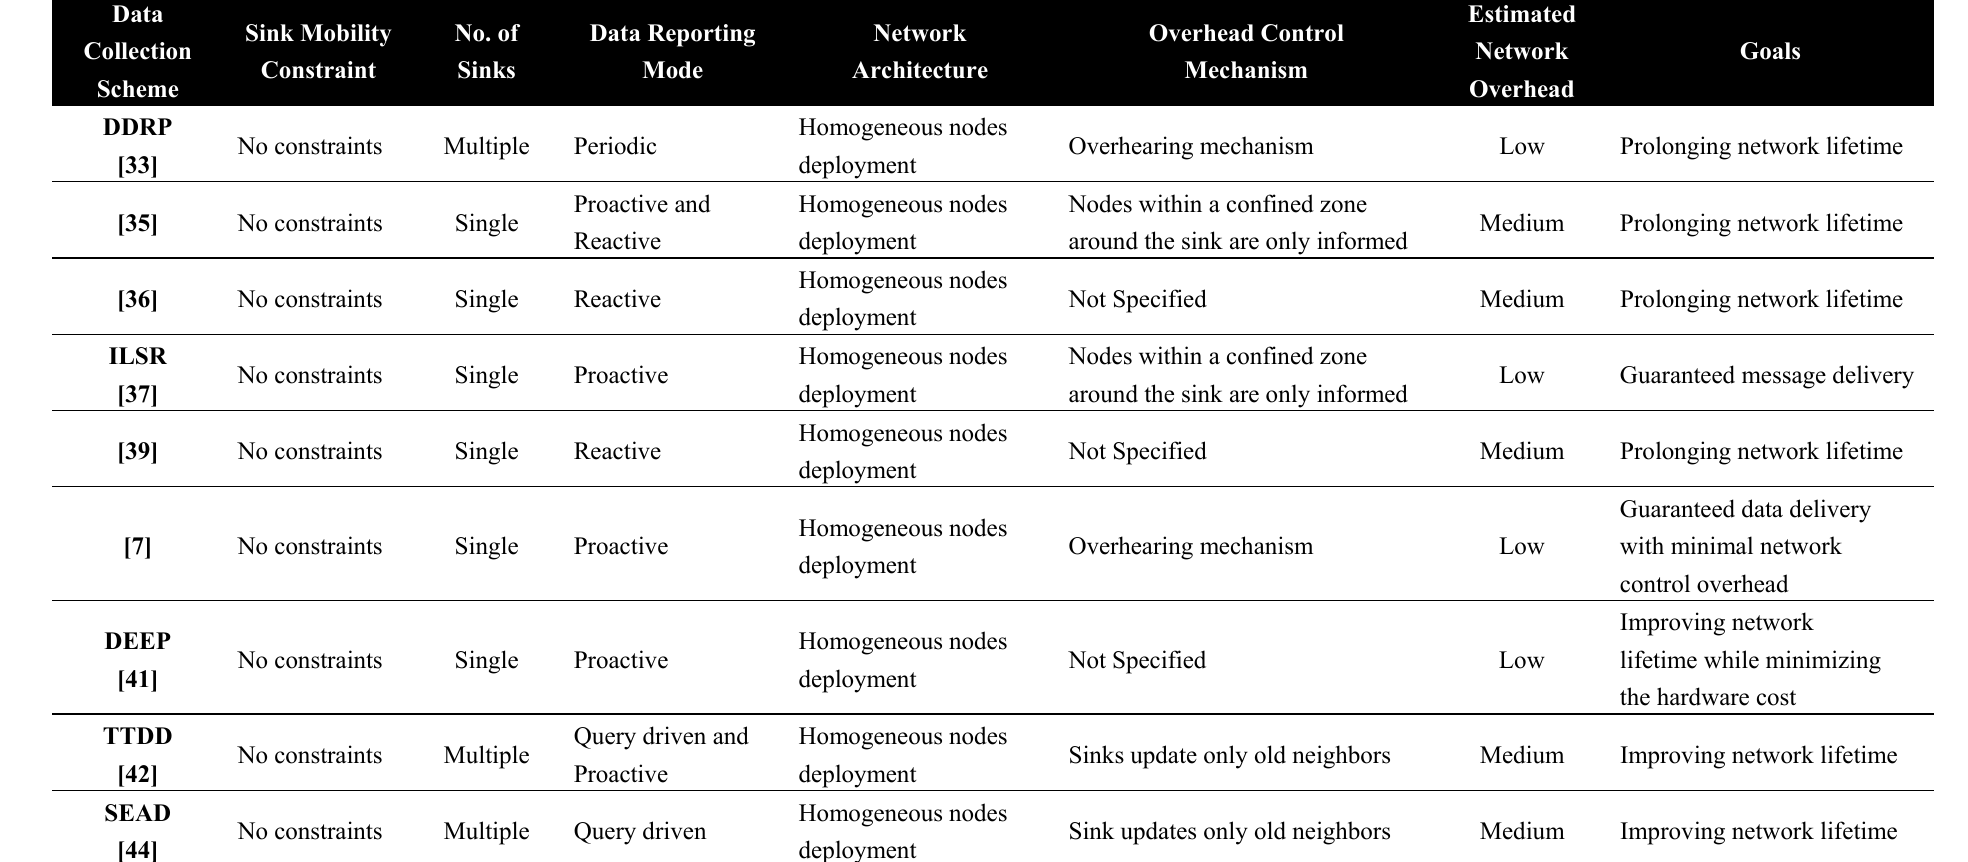
Table 2. Summary of path unconstrained based data collection